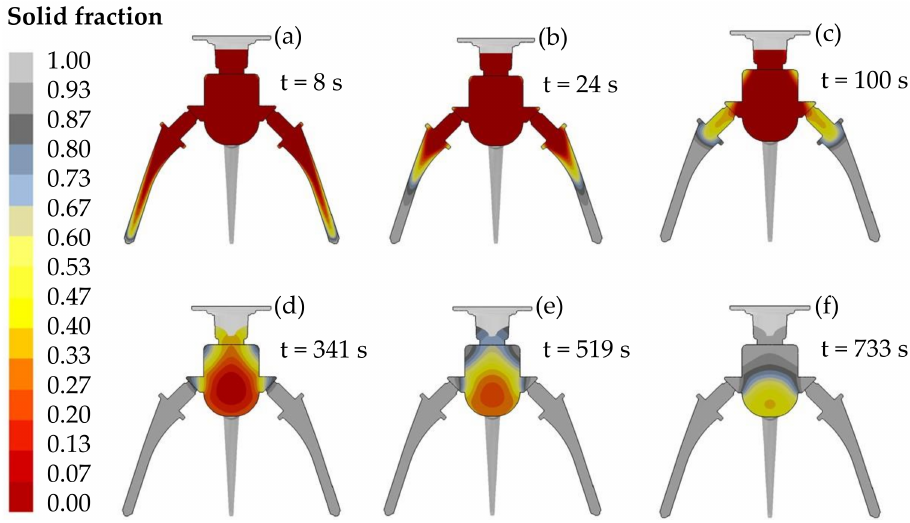
Figure 22. Solidification process of the hip prostheses model (cross section view). ( a ) 8 s; ( b ) 24 s;